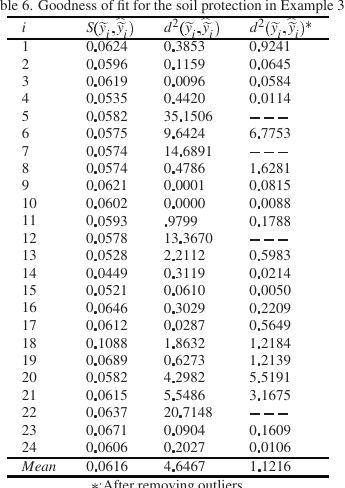
Table 6. Goodness offitforthe soilprotectionin Example3. i S y i y i